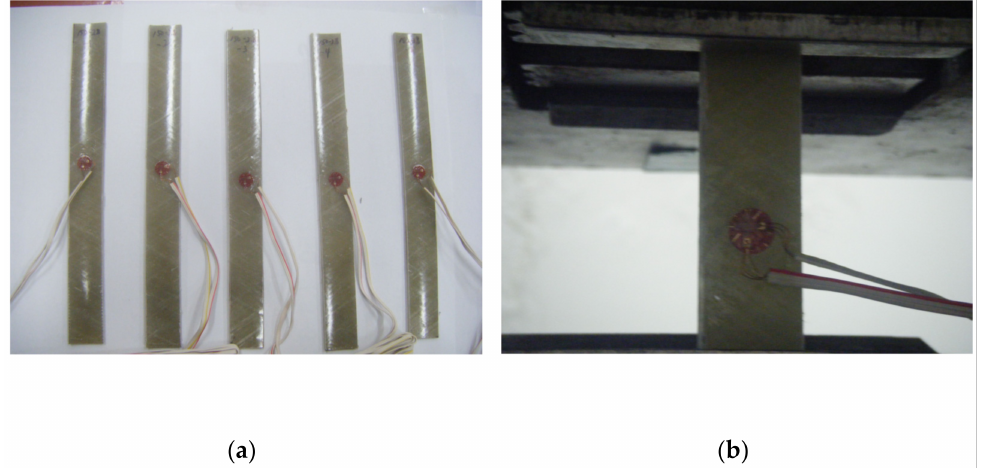
Figure 4. Setup of the filament winding FRP (FFRP) tensile test: ( a ) specimen, ( b ) attachment of strain gauge.